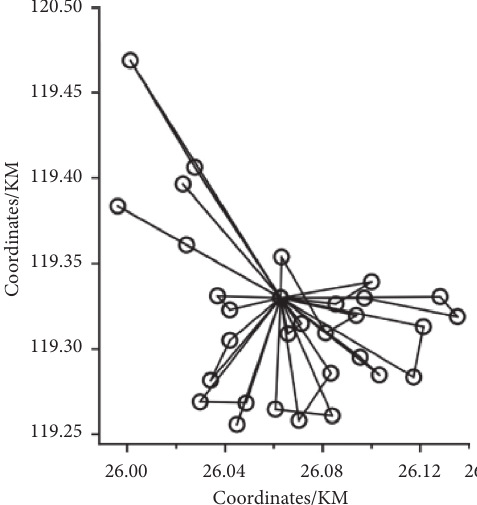
Figure 3: Returned routes from the general warehouse to the front warehouses.